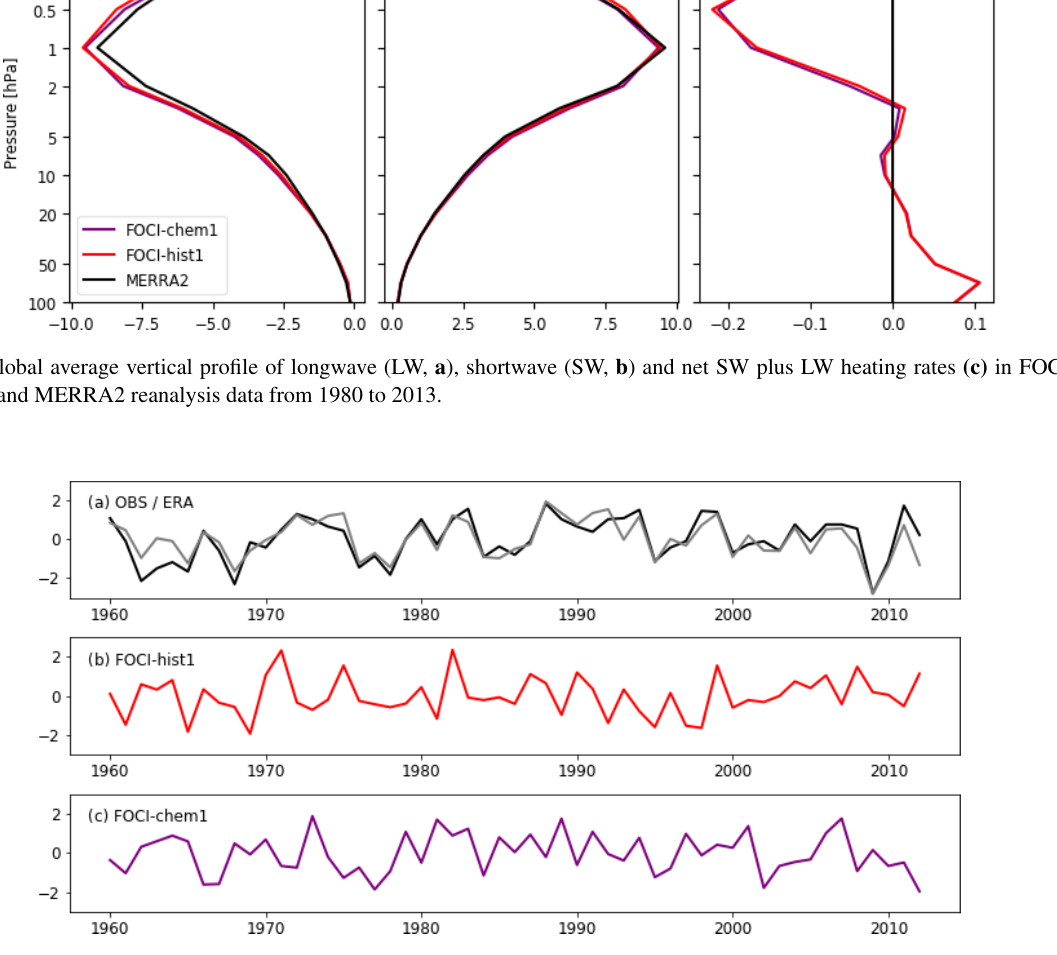
Figure A6. NAO time series derived from (a) Hurrel’s station-based index (black) and ERA-Interim reanalysis (grey), (b) FOCI-hist1 and (c) FOCI-chem1. Please see text on how the NAO time series are constructed.